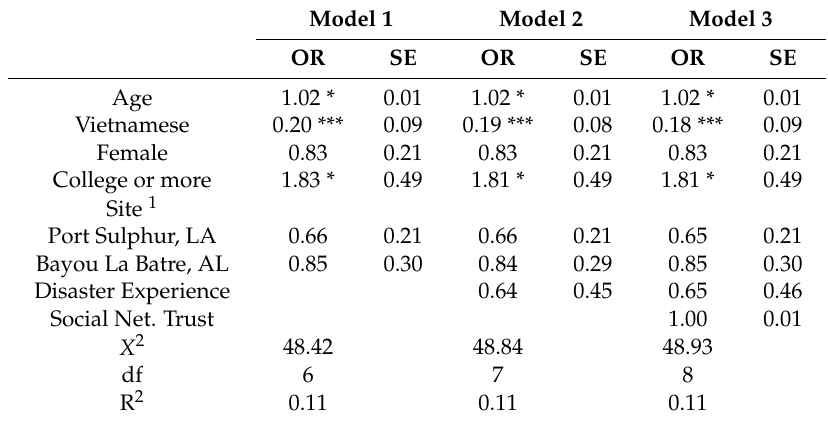
Table 2. Stepwise logistic regression predicting resilience (N =